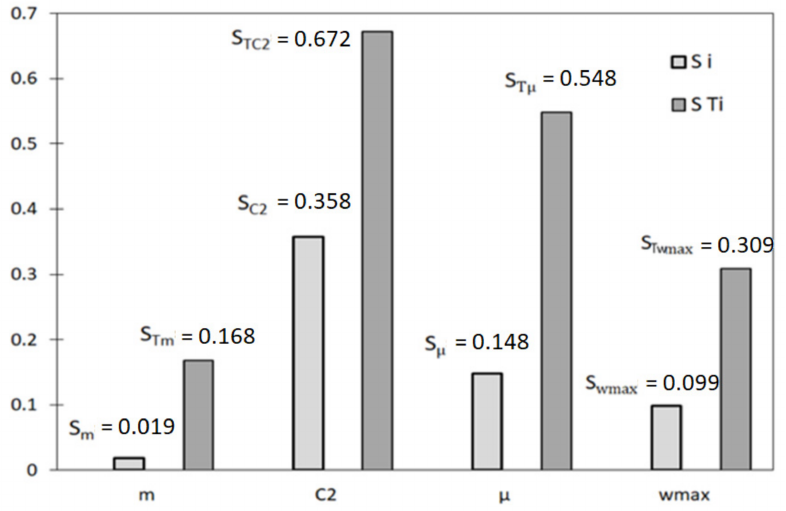
Figure 3. First order (S i ) and total (S Ti ) sensitivities for the analyzed parameters ( m , C 2 , µ , w max ) of Deardorff equation.